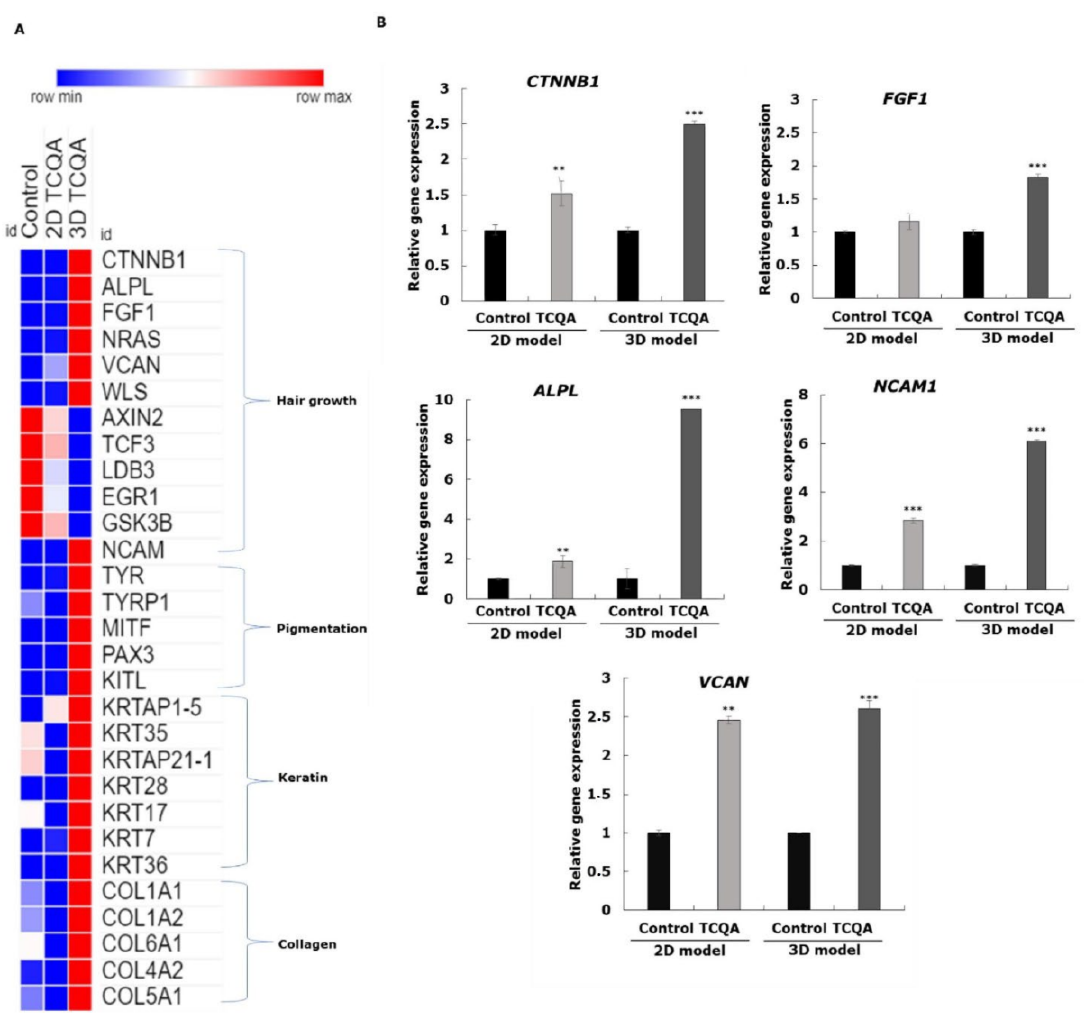
Figure 5. The enriched biological function categories regulated by the TCQA-treated 2D- and 3D-cultured HFDPCs and validation by gene expression analysis. ( A ) The heat map shows the comparison between 2D, 3D, and control. This displays genes related to several biological functions like hair growth, collagen, pigmentation, and collagen. The heat map was generated using the online tool Morpheus Broad Institute (https://software.broadinstitute.org/morpheus). ( B ) The gene expression of CTNNB 1 , ALPL , FGF1 , NCAM1, and VCAN. The result represents the mean ± SD from three independent experiments. A T-test was used to assess the level of significance between the groups.), ** statistically significant ( p -value ≤ 0.01), *** statistically significant ( p -value ≤